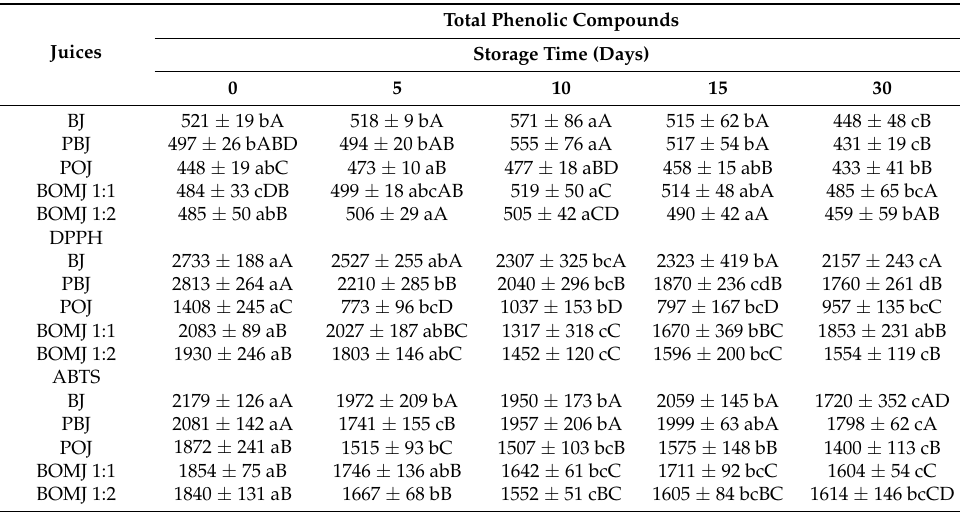
Table 4. Total Phenolic compounds ( µ g EAG/mL), DPPH Trolox ( µ g/mL), and ABTS Trolox ( µ g/mL) in juices stored at 4 ◦ C/30